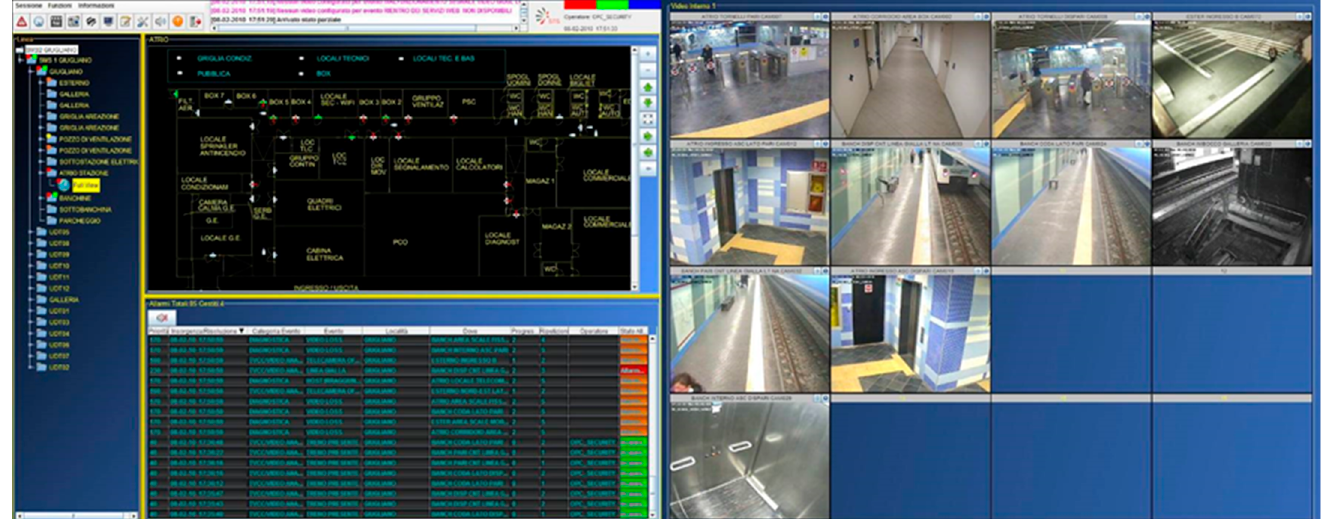
Figure 7. The railway on-route WSN graphical user interface.